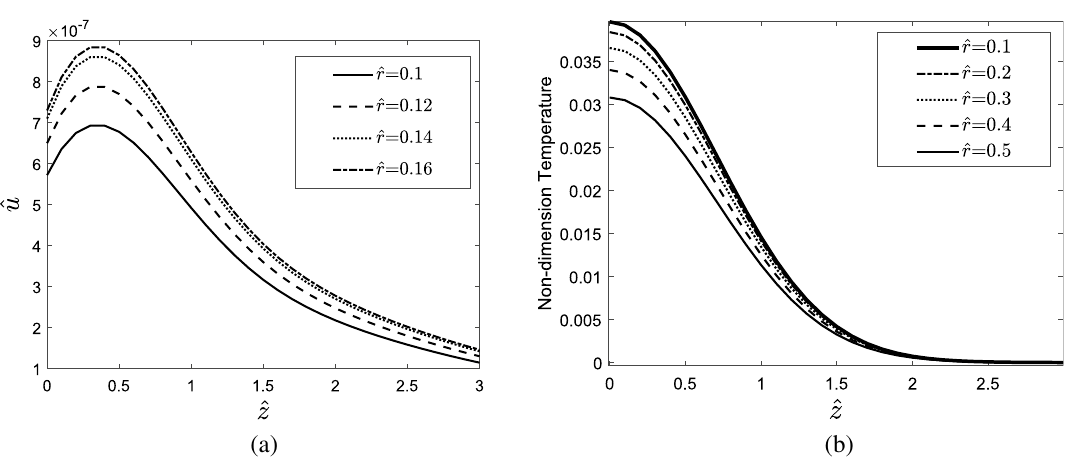
r z for different values of r (cid:31) (cid:31) (cid:31)